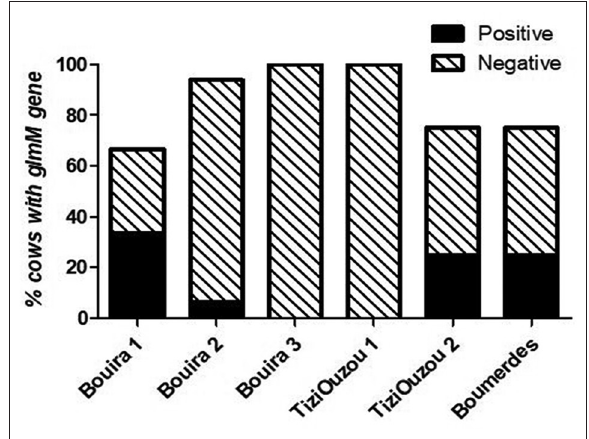
Figure-3: Occurrence of Helicobacter pylori in cows’ milk using polymerase chain reaction detection of the glmM